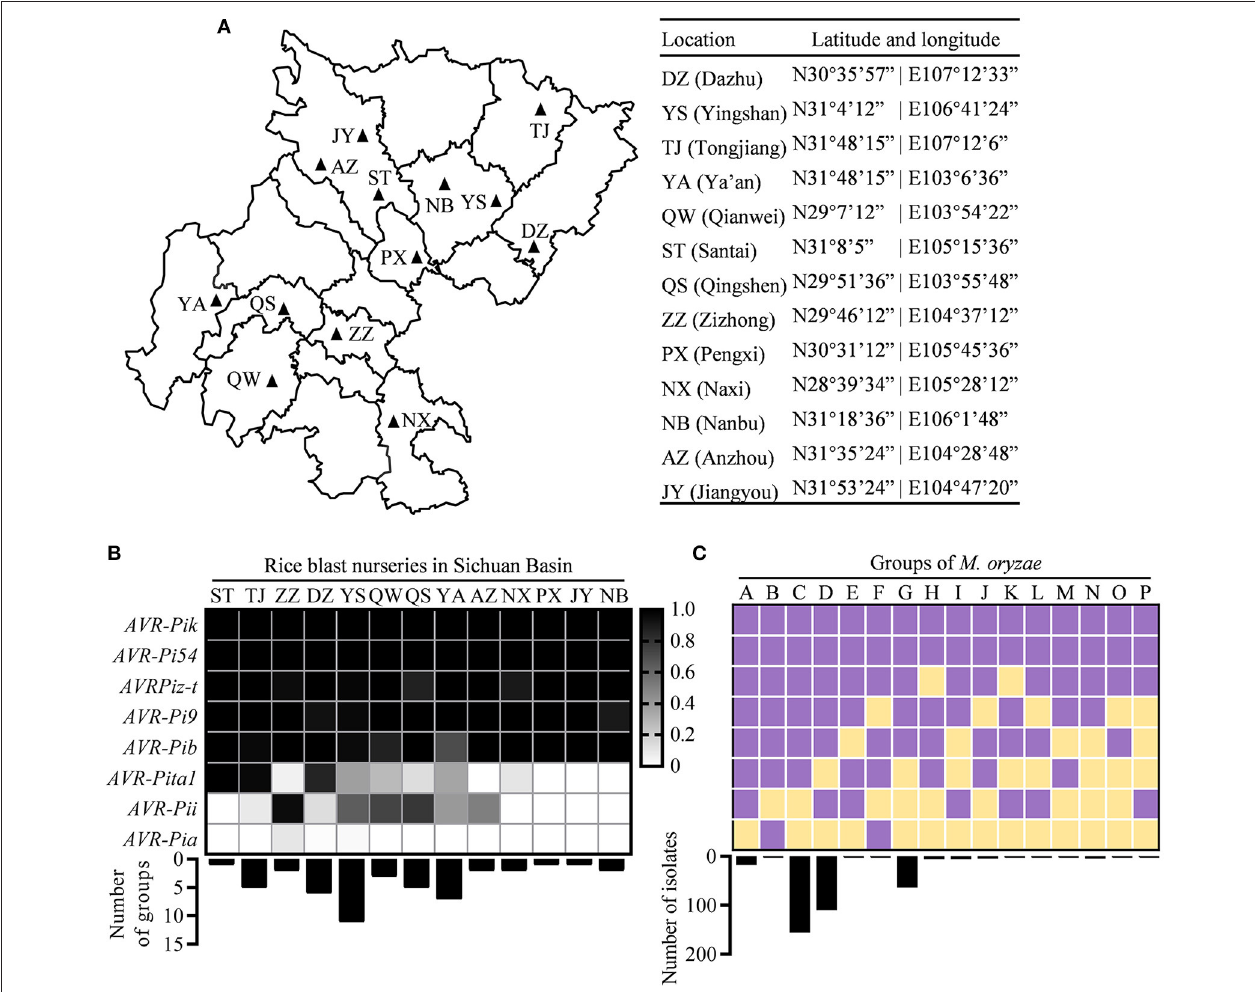
FIGURE 1 | Distribution of avirulence ( AVR ) genes in the Sichuan Basin. (A) Location of rice blast nurseries in the Sichuan Basin. (B) The distribution of eight AVR genes in the indicated nurseries. The presence of each AVR gene was indicated by shaded box (shadow key) in the 383 field isolates from 13 prefectures (top) where the strains formed different number of groups (bottom). (C) The classification of Magnaporthe oryzae ( M. oryzae ) strains based on the presence of AVR genes. Upper panel shows the presence/absence of each AVR gene and lower panel shows the number of isolates in each group. Purple, presence; yellow,